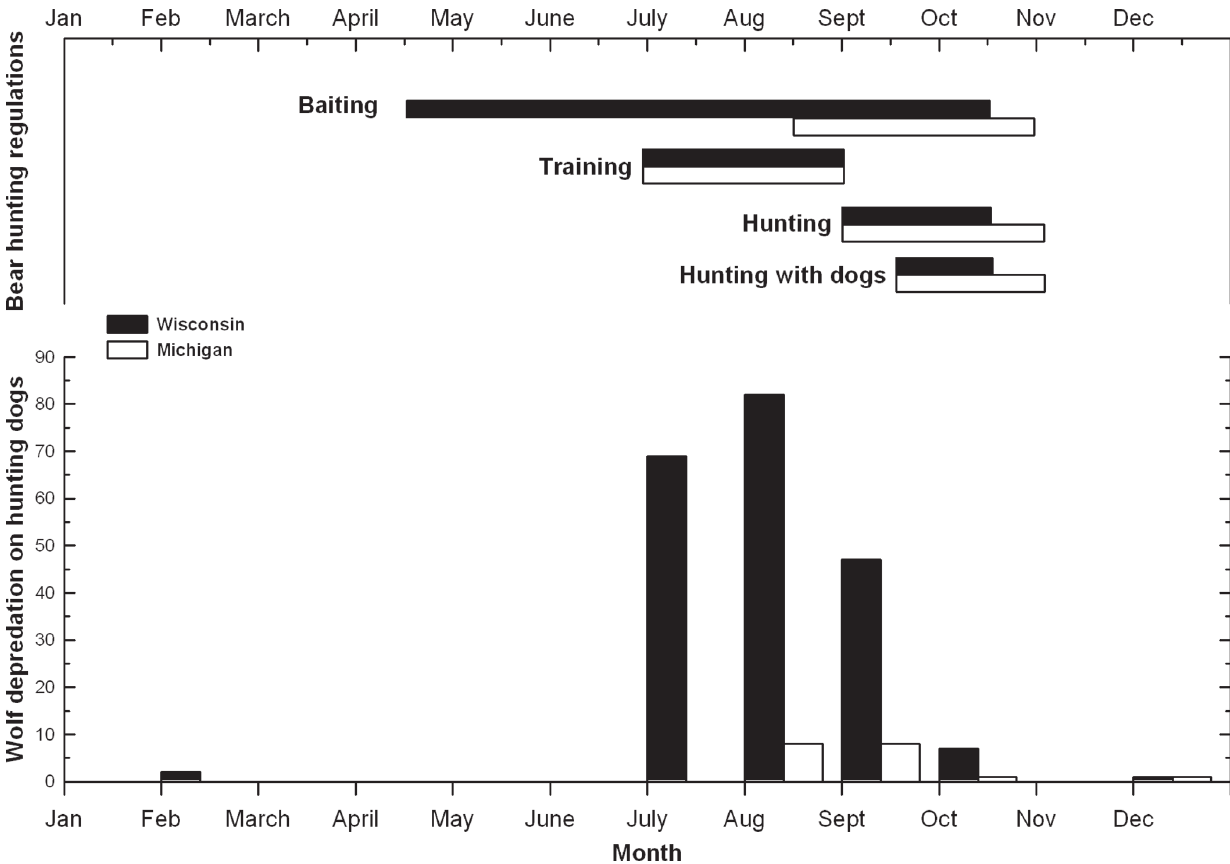
Figure 2. Wolf conflict timing and bear hunting in the upper Great Lakes region, USA. Lower panel : cumulative wolf depredations on bear- hunting dogs ( y-axis ) each month ( x-axis ) from 1980–2010 in Wisconsin ( closed bars ) and Michigan ( open bars ). Upper panel : General timing of bear- baiting, training, and hunting regulations ( y-axis ) in each state; x-axis and bar symbols are the same as in lower panel. In Wisconsin there is a pre- training baiting period of , 2.5 months that does not exist in Michigan and baiting in Michigan begins , 4 months later than in Wisconsin. doi:10.1371/journal.pone.0061708.g002 ( = e 2 0.0241 ; Table 2). Given the same time since training with bait of training with bait until the end of hunting with dogs (i.e., , 123 began, the odds of a depredation event occurring in Wisconsin days), the probability decreases from 0.87 to 0.26 in Wisconsin and were 3.57 6 (= e 1.273 ; Table 2) greater than the odds in Michigan from 0.41 to 0.36 in Michigan, indicating a relative risk 2.12–7.2 6 (Table 1; Fig. 3). For example, as time increases from the first day greater in Wisconsin.